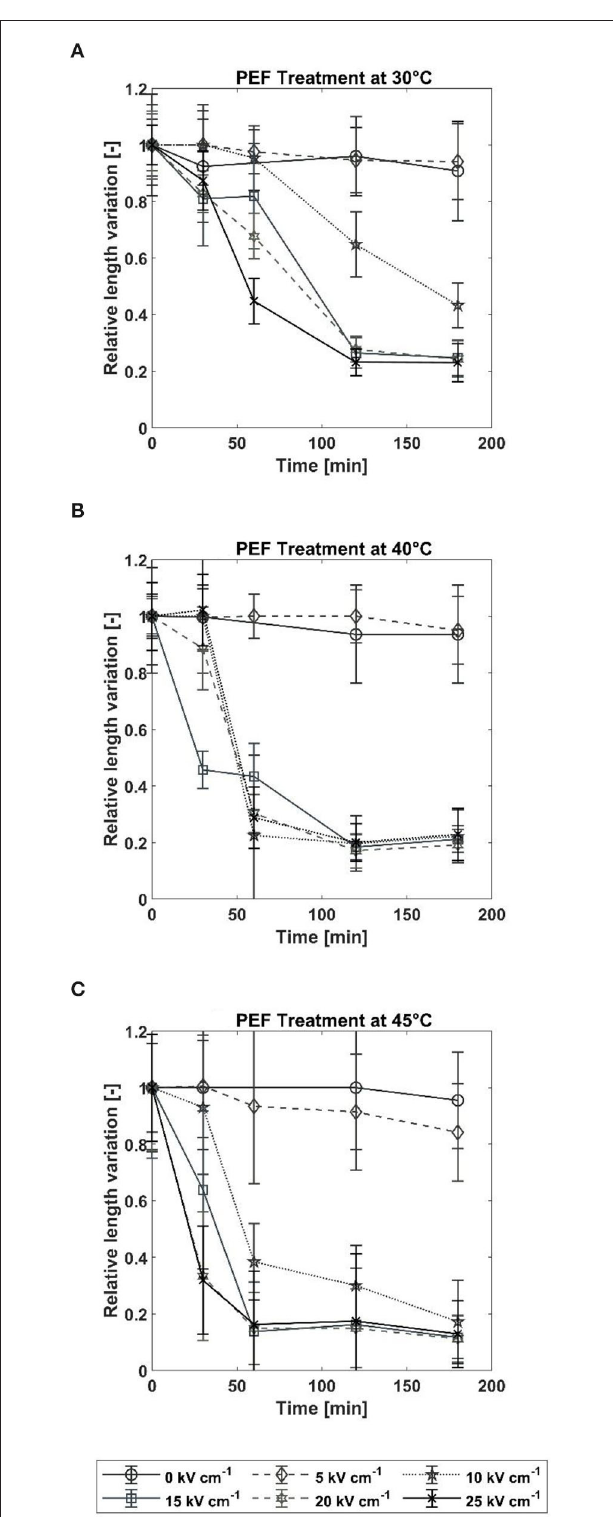
FIGURE 6 | Relative change in average particle size after PEF treatment at (A) 30 ◦ C, (B) 40 ◦ C, and (C) 45 ◦ C. The error bars show the deviations of the detected particles from the mean value and thus represent the width of particle size